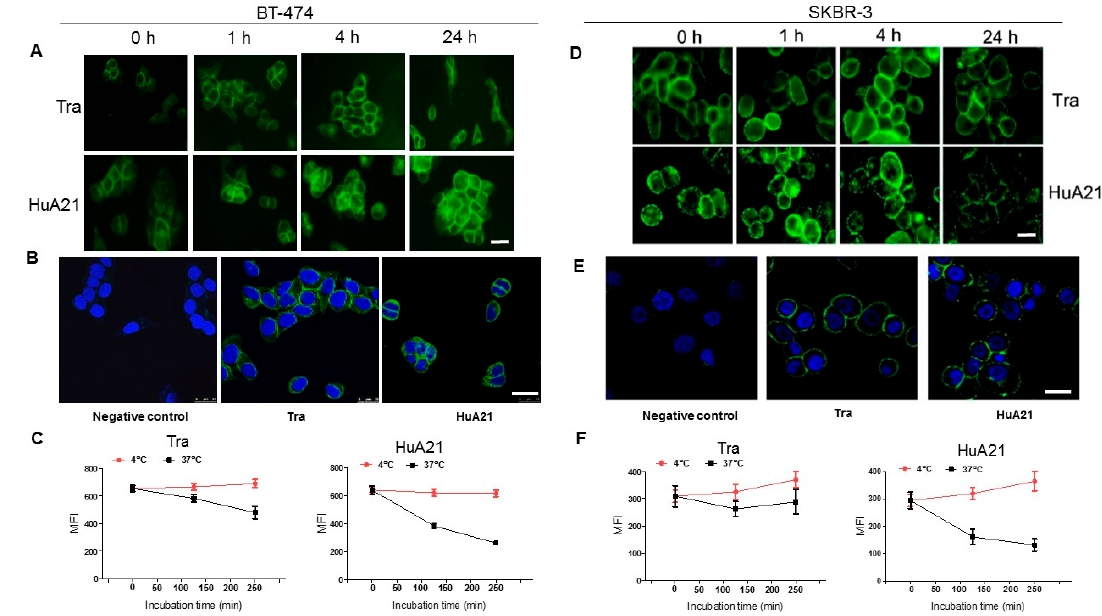
Figure 5. HuA21 enabled internalization in HER2-positive cancer cells. ( A ) The BT-474cells were incubated with FITC-conjugated HuA21 or FITC-conjugated trastuzumab (Tra) for the indicated time periods, and then the presence of HuA21 or Tra was revealed by fluorescence microscope. Representative photomicrographs showing HuA21 or Tra (Green: FITC-conjugated HuA21 or Tra, scale bar = 50 µm); ( B ) The BT-474 cells were incubated with HuA21 or Tra for 4 h, FITC-conjugated secondary antibody was added and the signal was detected by confocal microscopy (Green: FITC-conjugated HuA21 or Tra; nuclei (blue) was stained by 4’,6-diamidino-2-phenylindole (DAPI), scale bar = 50 µm); ( C ) The BT-474cells were incubated with Tra or HuA21 for the indicated periods. HuA21 or Tra on the cellsurface was labeled with a FITC-conjugated secondary antibody and analyzed by flow cytometry; ( D ) The SKBR-3 cells were incubated with FITC-conjugated HuA21 or FITC-conjugated trastuzumab (Tra) for the indicated time periods, and then the presence of HuA21 or Tra was revealed by fluorescence microscope. Representative photomicrographs showing HuA21 or Tra (Green: FITC-conjugated HuA21 or Tra, scale bar = 50 µm); ( E ) The SKBR-3 cells were incubated with HuA21 or Tra for 4 h, FITC-conjugated secondary antibody was added and the signal was